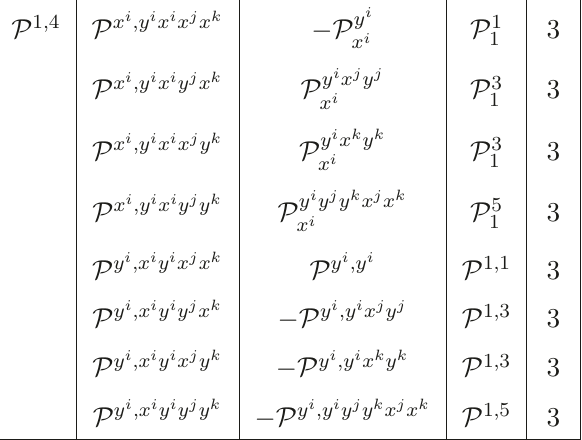
Table 1. All the RR, NS and P fluxes that can be turned on in the N = 1 orientifold model for both IIB and IIA. Here and in the rest of the paper, we choose the convention that to map the IIB to the mirror IIA theory we first perform a T-duality along x 1 , then along x 2 and finally along x 3 . The indices i, j, k are always meant to be in cyclic order. In the last column we give the number of independent components for each flux. There are in total 8 RR fluxes, 32 NS fluxes and 48 P